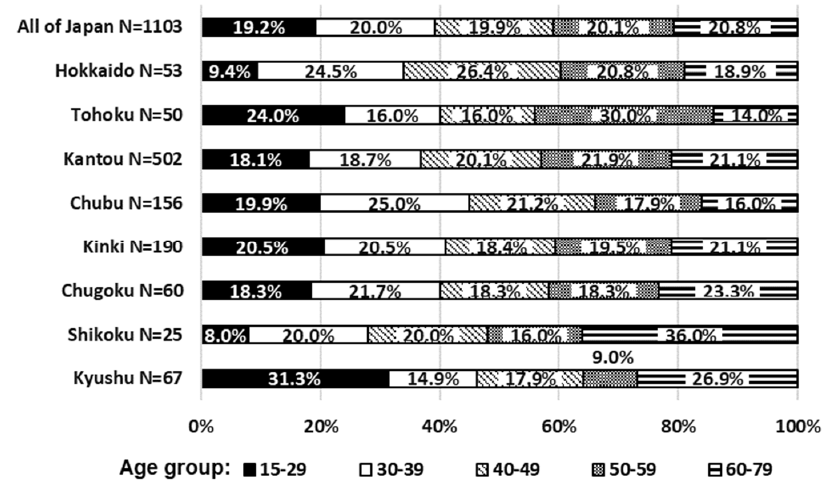
Figure 2. Regional distribution of respondents by age